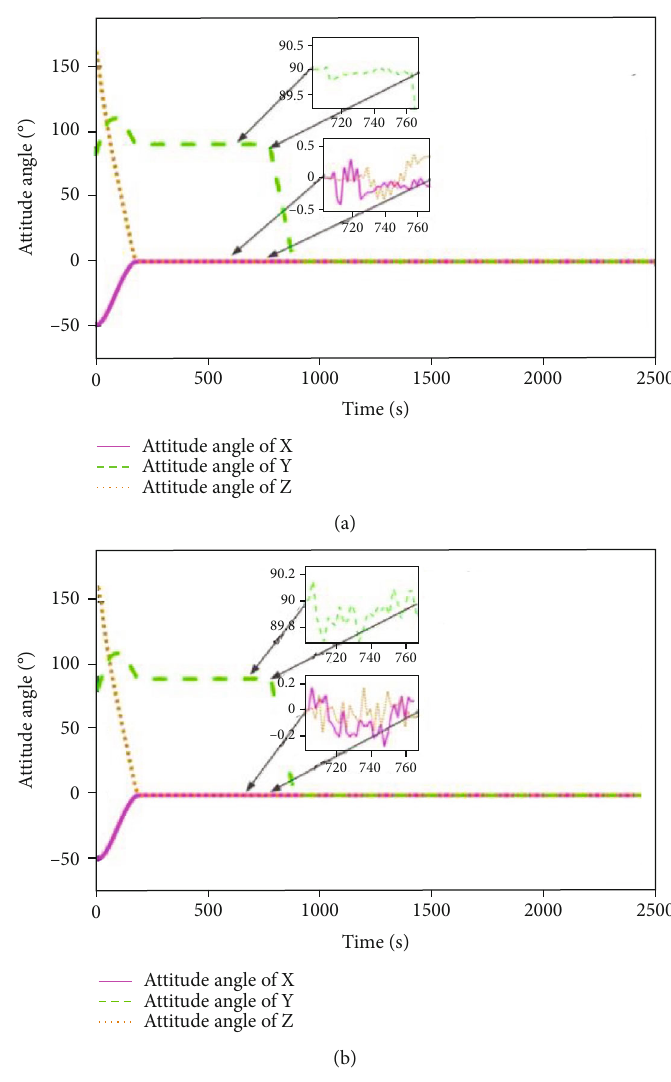
Figure 7: Attitude angle curve. (a) PD control. (b) RBF Neural network